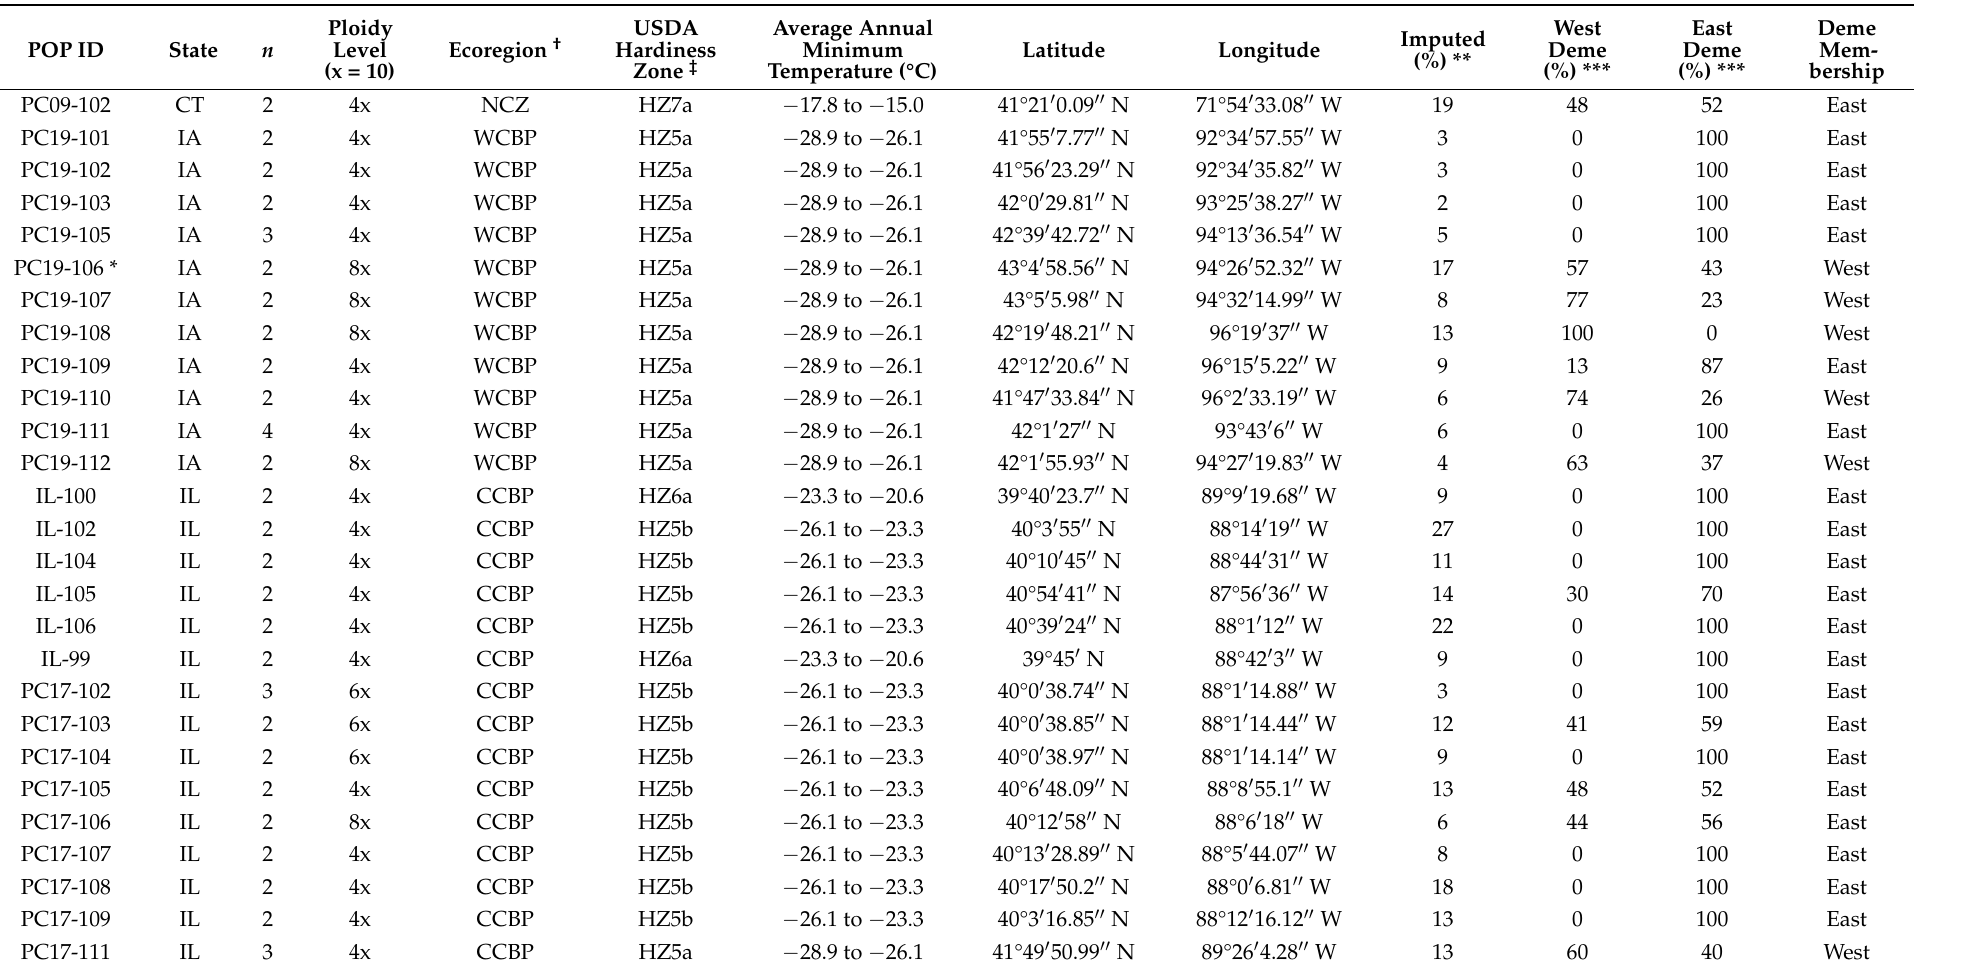
Table A1. Ploidy levels, USDA hardiness zones (PHZ), Level III ecological regions of North America, average annual minimum temperature (°C), longitude and latitude of origin, missing data imputed (%), and membership of deme of 96 prairie cordgrass ( Spartina pectinata Link)